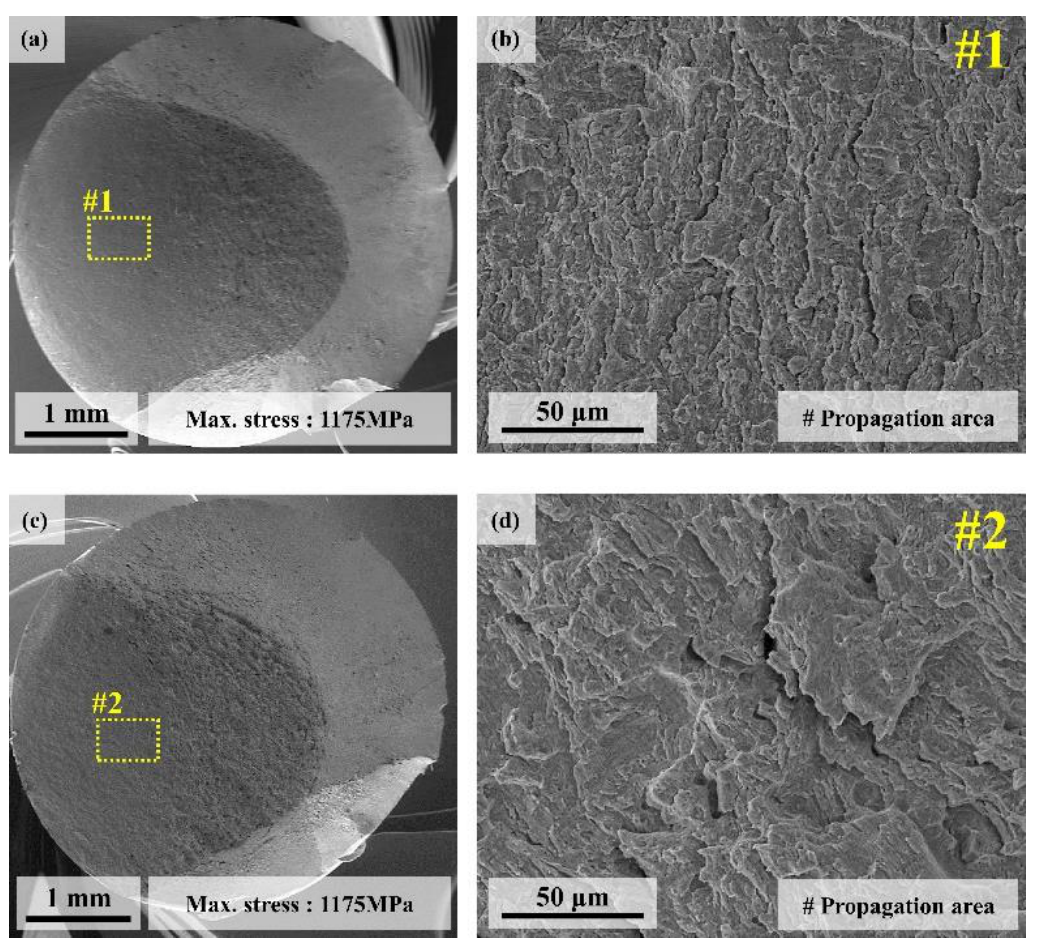
Figure 14. ( a ) SEM overview image of high-cycle fatigue fractography of alloy A; ( b ) high magnification SEM image of fatigue crack propagation area; ( c ) SEM overview image of high-cycle fatigue fractography of alloy B, and ( d ) high magnification SEM image fatigue crack propagation area.